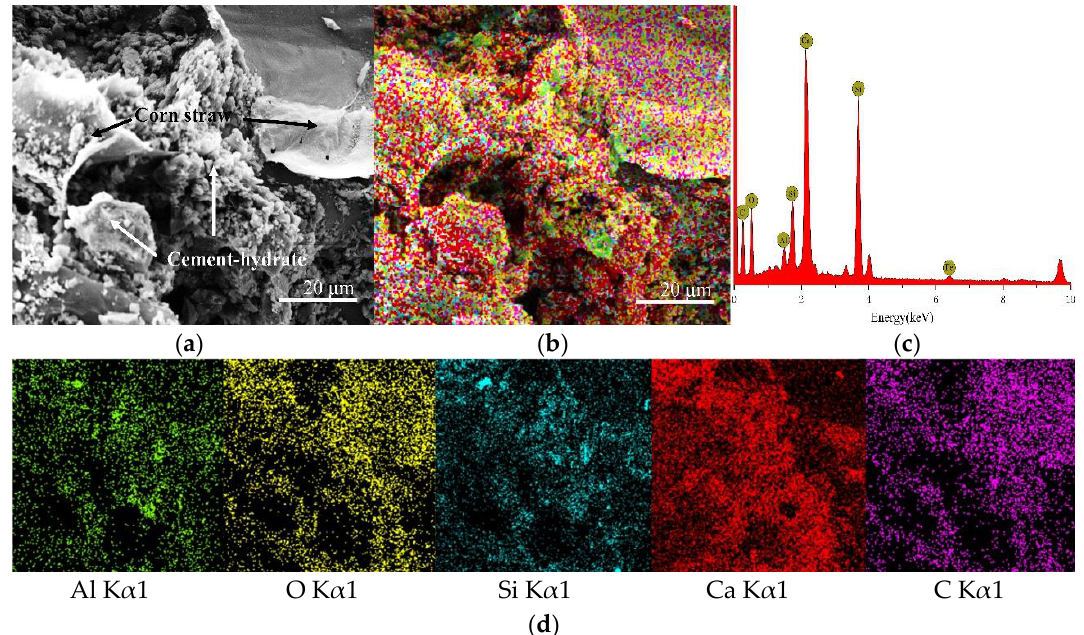
Figure 14. EDS scanning diagram of CSCC-5: ( a ) SEM of CSCC, ( b ) element distribution of CSCC, ( c ) energy spectrum of CSCC, ( d ) single element distribution diagram.